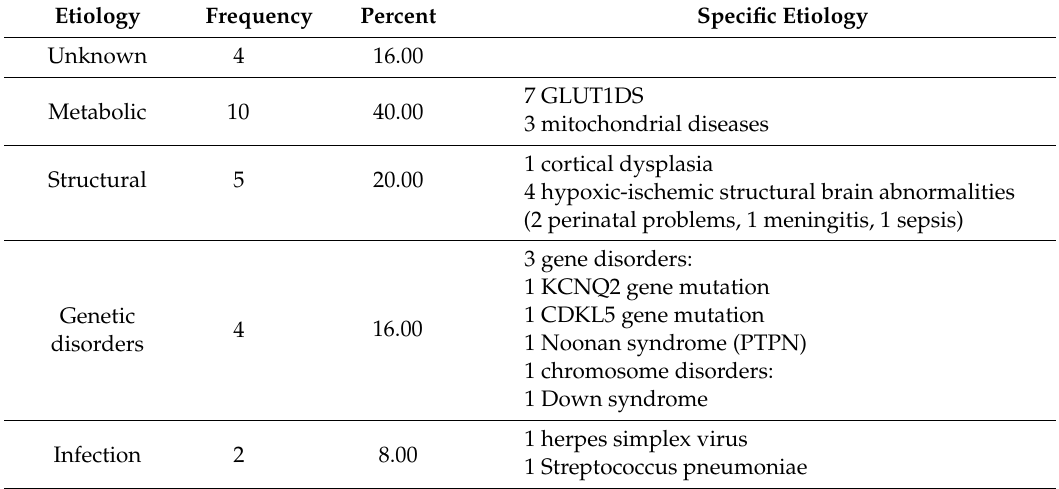
Table 2. Etiology of